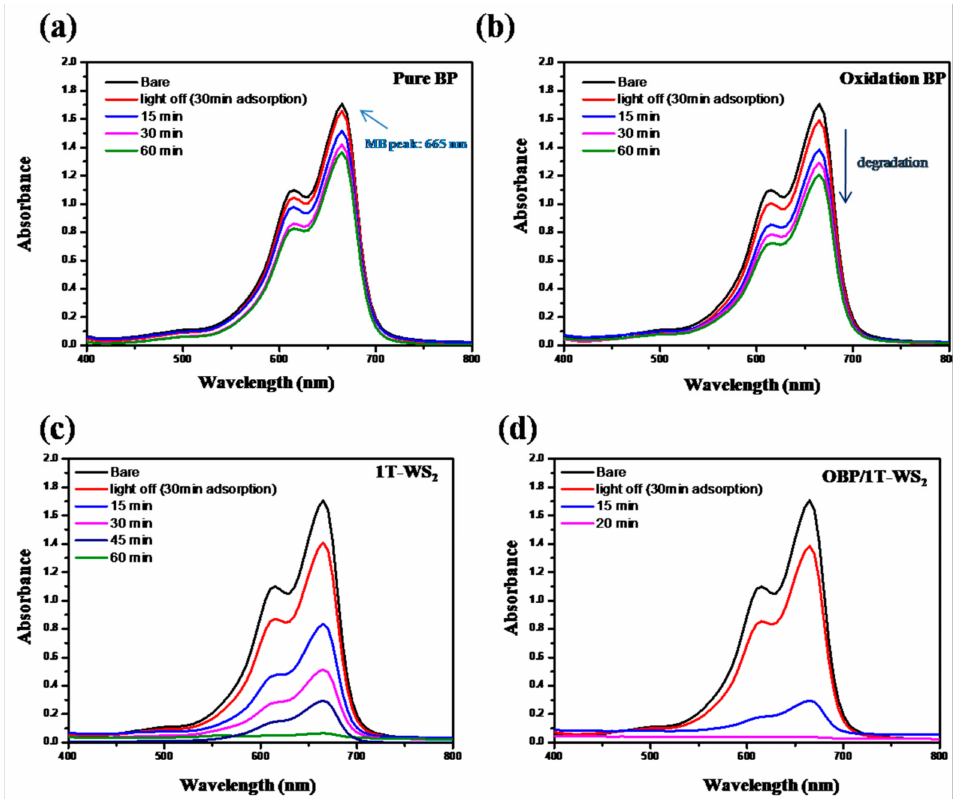
Figure 6. UV-Vis spectra of the methylene blue solution (20 ppm), which was degraded after adding various samples separately: ( a ) pure black phosphorus, ( b ) oxidized BP, ( c ) 1T-WS 2 , and ( d ) OBP/1T- WS 2